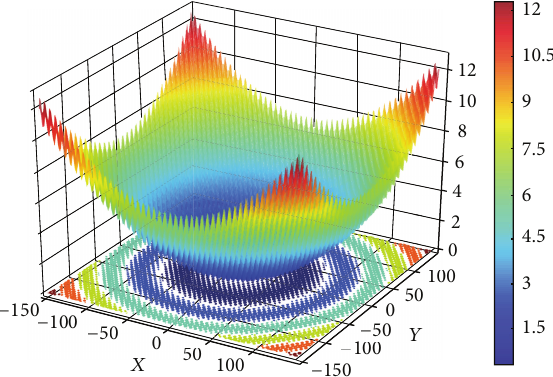
Figure 3: This is a two-dimensional surface plot of Griewangk’s function. The global optima are at [0,0] , where the function evaluates to